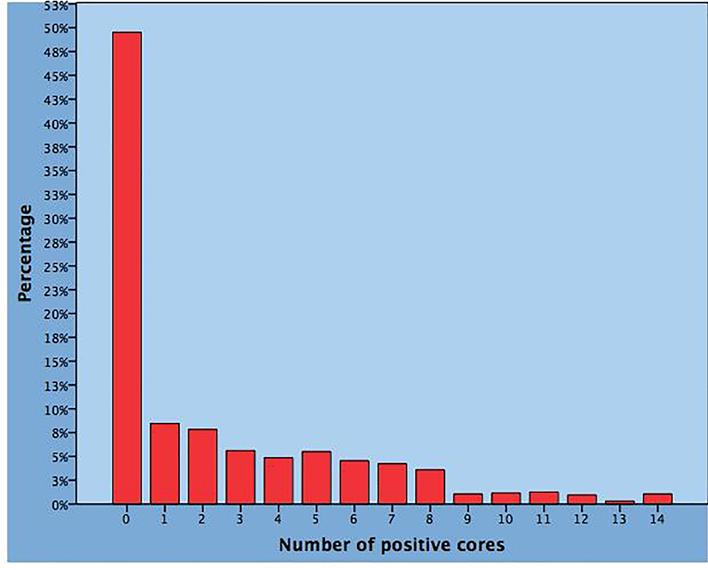
Figure 1 - ercentages of negative and positive cores in 945 patients who underwent standard baseline trans-perineal biopsies because of suspected prostate cancer.